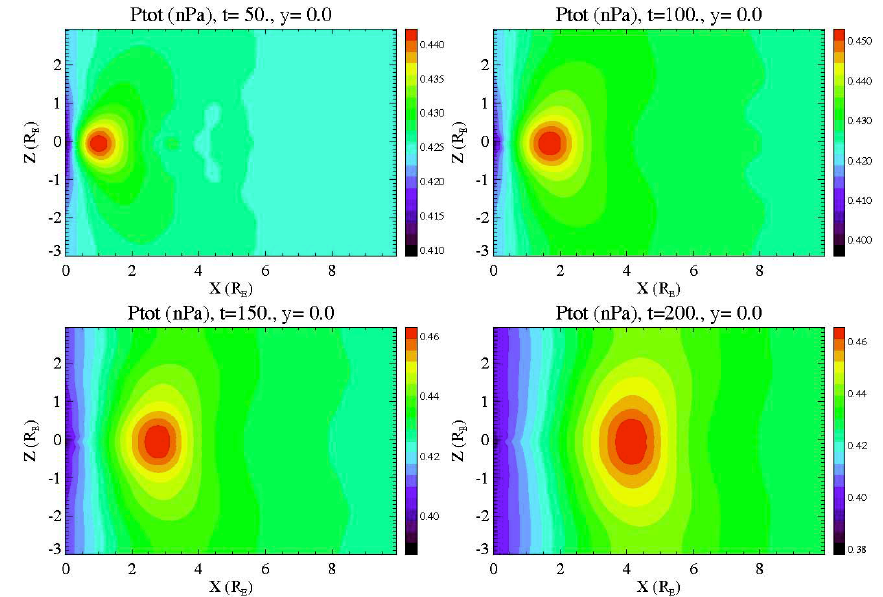
Fig. 3. Contours of the total pressure ( p + B 2 / 2 µ 0 ) in the y =0 plane at the same times as in Fig. 2.